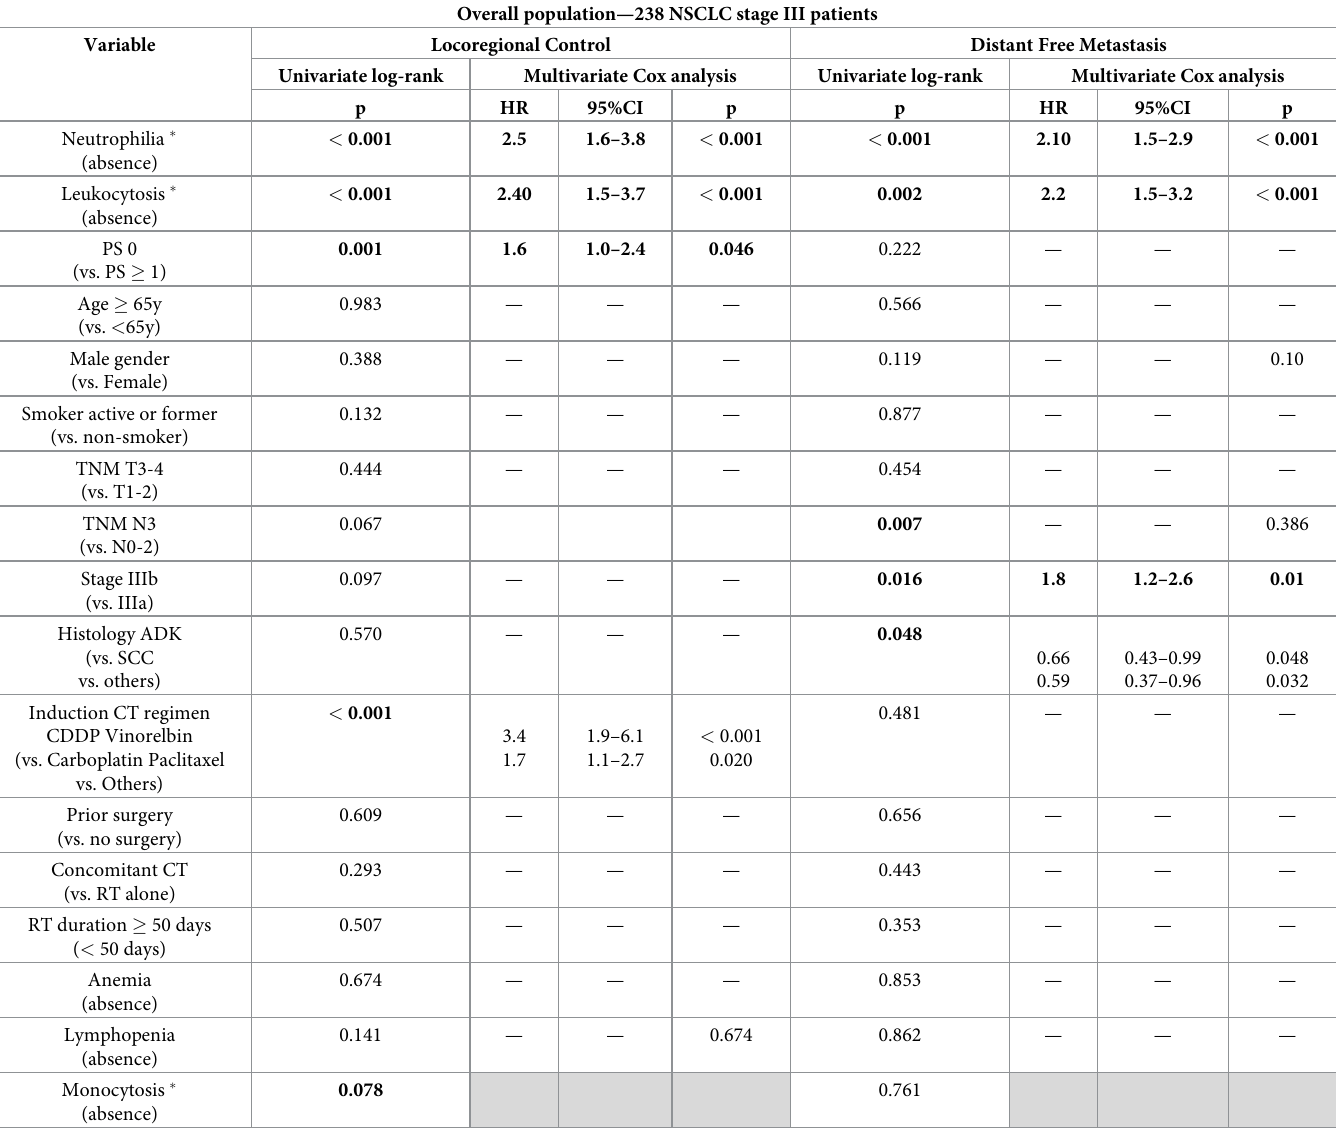
Table 3. Results of univariate and multivariate (Cox) analyses for locoregional control and Distant Free Metastasis (significant factors in bold). Overall population—238 NSCLC stage III